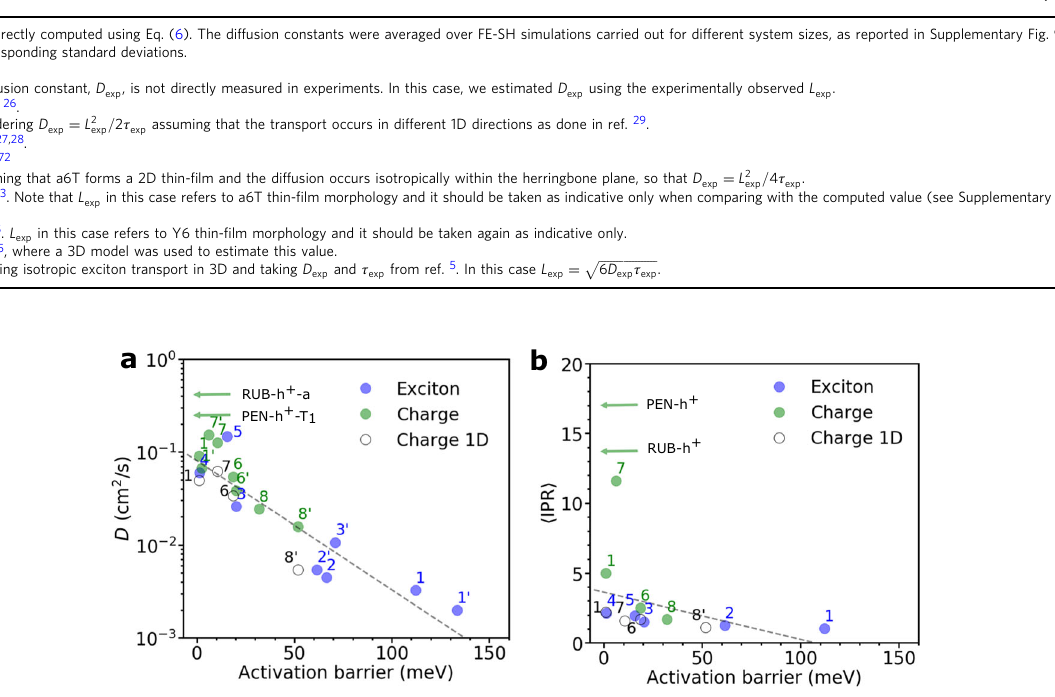
Fig. 5 Comparison charge vs exciton transport. Correlation between a the diffusion constant ( D , Eq. (6)) and b the time average inverse participation ratio (IPR, Eq. (8)) of charges and excitons against the activation barrier (Eq. (1)) for different systems, respectively. Data from present exciton transport simulations are depicted in blue (ANT (1), a6T (2), PDI (3), DCVSN5 (4), and Y6 (5)). Data for charge transport simulations for the 2D conductive layers of OSs are taken from ref. 49 and depicted in green (ANT (1), naphthalene (6), perylene (7), pMSB (8), rubrene (RUB), and pentacene (PEN)). For 2D simulations, two data points are shown for diffusion constant and activation barrier, one for the direction of highest coupling (unprimed number) and one for the direction of second highest coupling (primed number). PEN-h + - T 1 and RUB-h + - a denote hole transport along a crystallographic direction indicated. For comparison, 1D charge transport simulations (taken from ref. 8 ) are indicated by empty black circles and the values reported along the chain direction. The best linear fi ts to the data are indicated by dashed gray